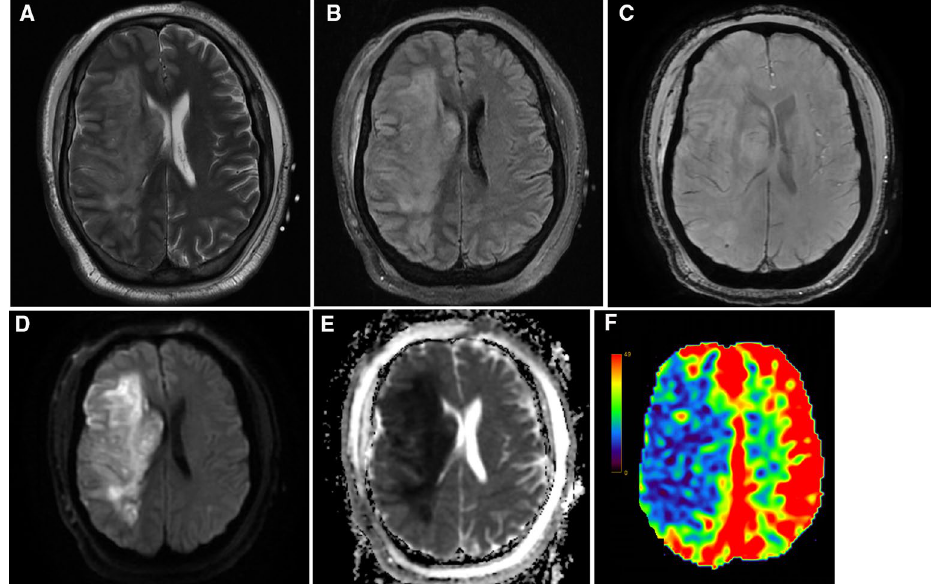
Fig. 3 Acute infarction with no ischemic penumbra: 75 years old female patient complaining of left hemiplegia since 10 h. A T2WI, B FLAIR, C SWI, D DWI, and E ADC map show acute ischemic infarct at the right frontoparietal region along the territory of the right MCA. ASPECTS score was 3/10. F ASL perfusion at 1.5 s shows corresponding area of hypo perfusion (no diffusion perfusion mismatch) without ischemic penumbra, aCBF gm 100/min—rCBF 62% to contra lateral side. aCBF absolute cerebral blood flow, ADC apparent diffusion coefficient, ASL arterial spin labeling, = ASPECT Alberta Stroke Program Early CT Score, DWI diffusion weighted image, rCBF relative cerebral blood flow, SWI susceptibility weighted